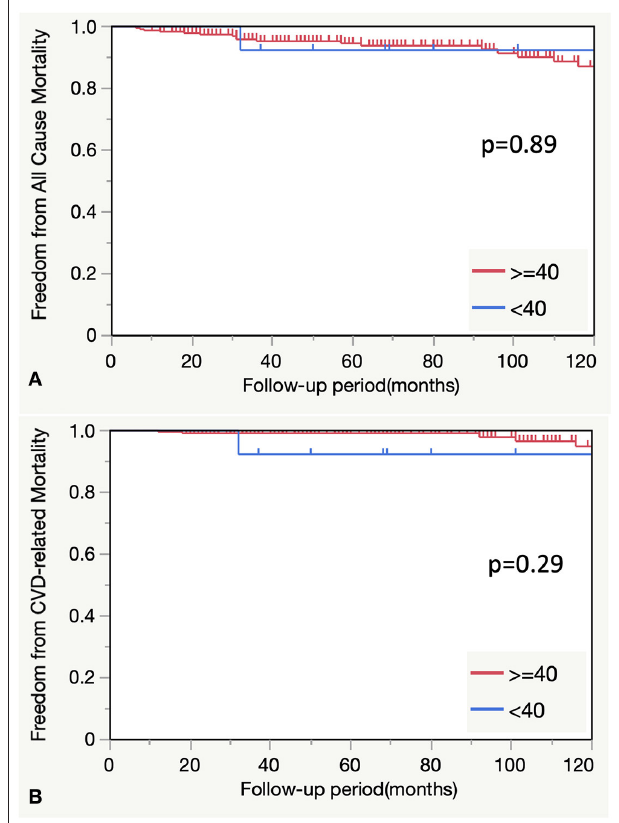
FIGURE 3 | (A) Comparison of all-cause mortality between the < 40-and ≥ 40-year age groups. (B) Comparison of CVD-related mortality between the < 40- and ≥ 40-year groups. CVD, cardiovascular